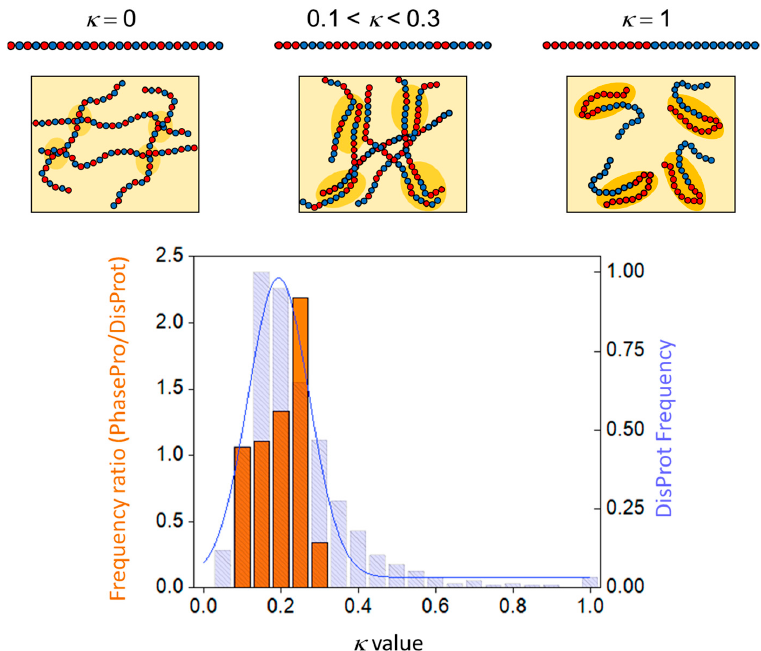
Figure 5. Charge decoration and propensity to undergo electrostatically driven phase separation. ( Top ) Lys-Glu sequences of different κ values, with K and E residues in red and blue, respectively. Charge distribution is related to protein compactness and phase separation (square boxes). κ = 0: attractions within and among polyampholytes lacking long same-charge clusters are weak. These chains are overall expanded and show weak scarcely cooperative inter-chain interactions, as symbolized by small ovals in pale yellow (scheme inspired by [46]). 0.1 < κ < 0.3: most favorable inter-chain interactions among chains presenting blocks of segregated charges. κ = 1: complete, or almost complete, charge segregation favors strong intra-chain interactions (dark yellow areas) that, reflecting monomolecular events, efficiently out compete inter-chain attractions. ( Bottom ) IDP / IDR propensity to undergo electrostatically driven LLPS as a function of κ values. The orange histogram shows the ratio between PhasePro (subset of electrostatically driven phase separation) and DisProt k-class frequencies [159] (left vertical axis). The κ -class frequencies from DisProt are shown as the shadowed blue bar histogram (right-hand vertical axis). Sequences from the PhaSePro database were manually retrieved and further analyzed for their level of disorder by IUPred [161]. Only regions with an overall disorder level higher than 0.6 (in a scale 0–1) were used to compute κ values. The latter were calculated through CIDER webserver (http: // pappulab.wustl.edu / CIDER / , [11]). DisProt entries were filtered by discarding sequences shorter than 20 amino acids or devoid of charged residues (FCR = 0) and redundant sequences. Two sequences were considered redundant if they were associated to the same DisProt_ID and if the start (residues 1–20) and the end (last 20 residues) of the two compared regions are respectively